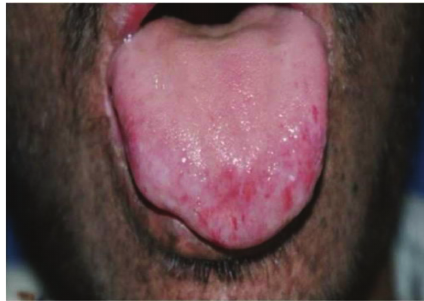
Figure 4: Precancerous lesion affecting the tip of the tongue. varying from the age of two to middle age [26, 28]. It is pre- sumed that as a consequence of defective DNA pathways